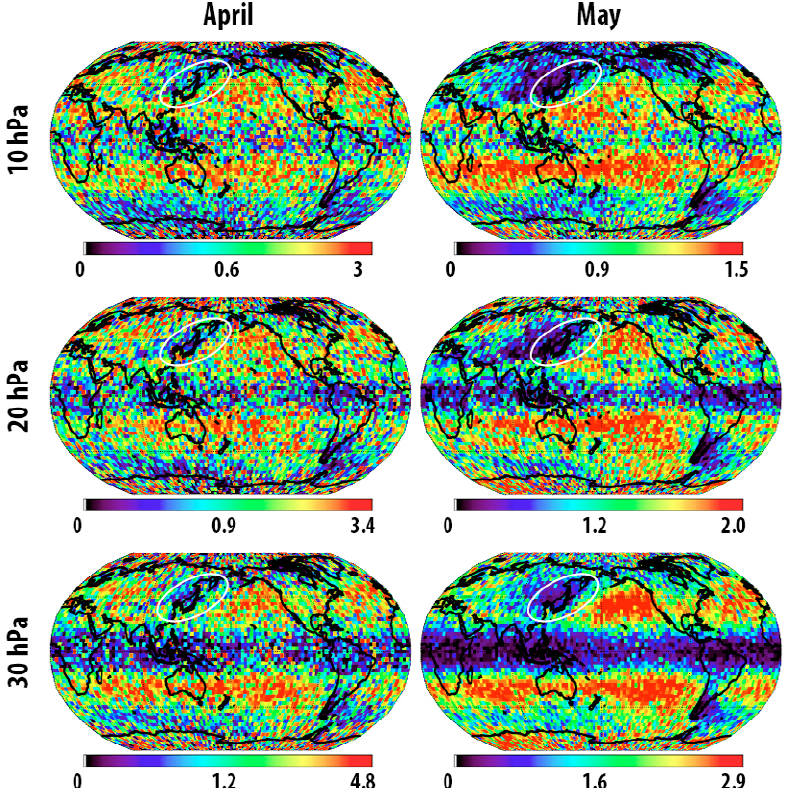
Figure 6. Selected monthly means of the gradient Richardson number at 10, 20 and 30hPa for 2007–2010 (non-linear colour scale